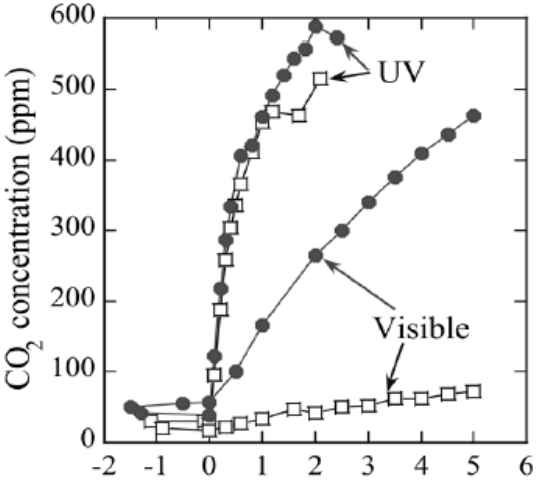
Figure 16. CO 2 evolution as a function of irradiation time (light on at zero) during the photodegradation of acetaldehyde gas (with an initial concentration of 485 ppm) under UV and visible light irradiation; TiO 2-x N x = solid circles, TiO 2 = open squares. From [65]. Reprinted with permission from AAAS, Copyright 2020.